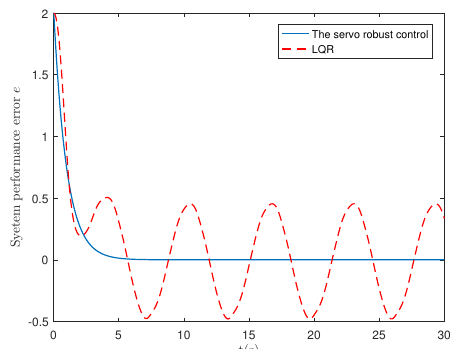
Figure 4. The system performance.